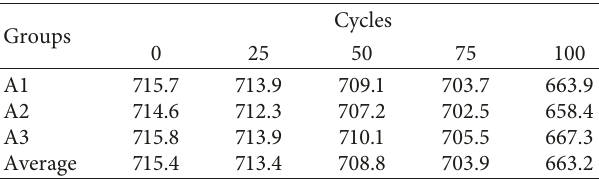
Figure 3: Surface changes during freeze-thaw cycles. (a) 25 cycles. (b) 50 cycles. (c) 75 cycles. (d) 100 cycles. Table 3: Masses of cement mortar after different freeze-thaw cycles (g).